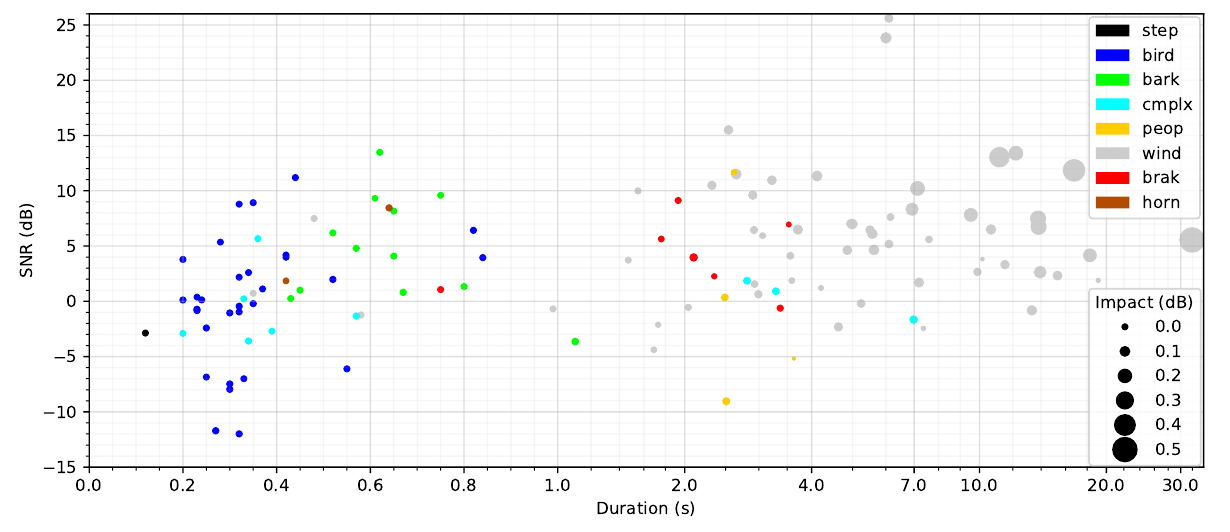
Figure 5: SNR, Impact and duration of all the